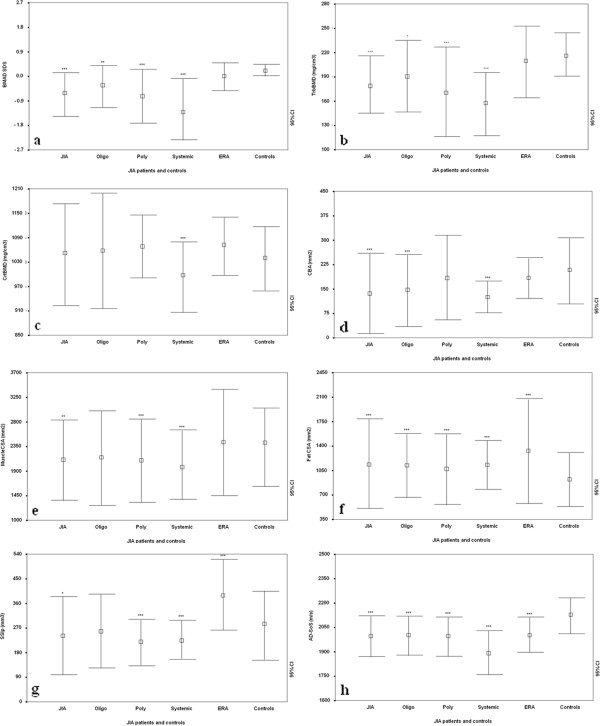
Transversal evaluation. Spine bone mineral apparent density (spine BMAD) SDS (a), trabecular bone mineral density (TrabBMD) (b), cortical bone mineral density (CrtBMD) (c), cortical bone area ([CBA) (d), muscle cross-sectional area (MuscleCSA) (e), fat cross-sectional area (FatCSA) (f), density-weighted polar section modulus (SSIp) (g), and Ad-SoS (h) in patients with oligoarticular, polyarticular, systemic, and enthesitis-arthritis (ERA) JIA versus controls. Bars represent means and 95% confidence intervals. **P < 0.005; ***P < 0.001.